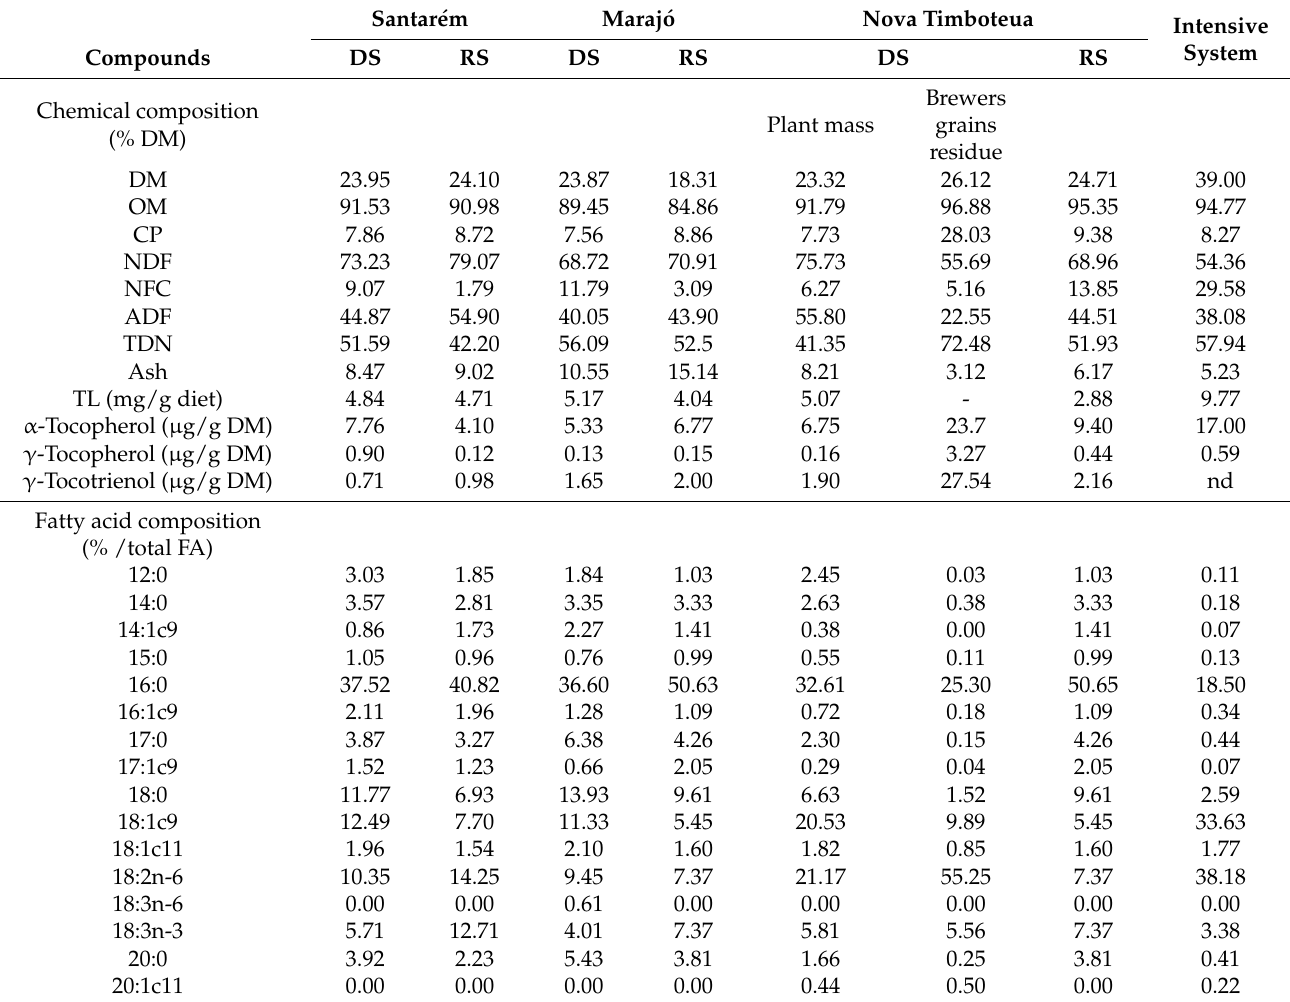
Table 1. Chemical composition of